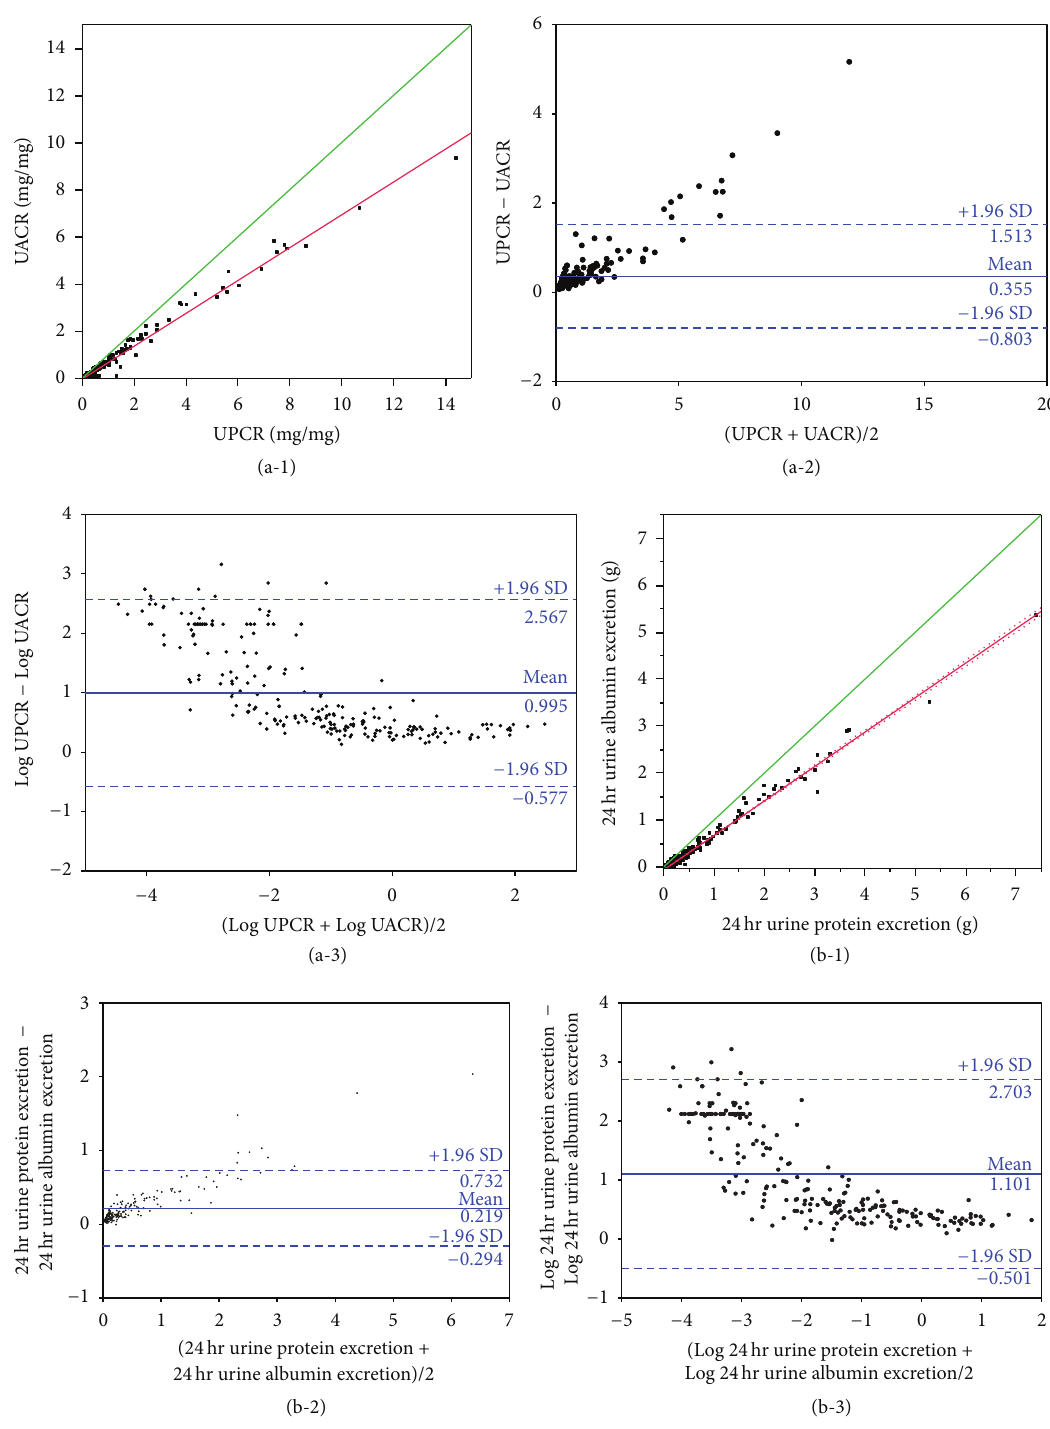
Figure 2: Urine albumin versus urine protein excretion. (a-1) UPCR versus UACR. Correlation 𝑟 = 0.99 , 95% CI 0.99-0.99. Bold line: line of identity; fine line: regression line; dotted lines: 95% CI of the regression line. (a-2) Limits of agreement of UPCR and UACR. (a-3) Limits of agreement of Log-transformed UPCR and UACR. (b-1) 24 hr urine protein excretion versus 24 hr urine albumin excretion. Correlation 𝑟 = 0.99 , 95% CI 0.99-0.99. Bold line: line of identity; fine line: regression line; dotted lines: 95% CI of the regression line. (b-2) Limits of agreement of 24hr urine protein excretion and 24hr urine albumin excretion. (b-3) Limits of agreement of Log-transformed 24 hr urine protein excretion and 24 hr urine albumin